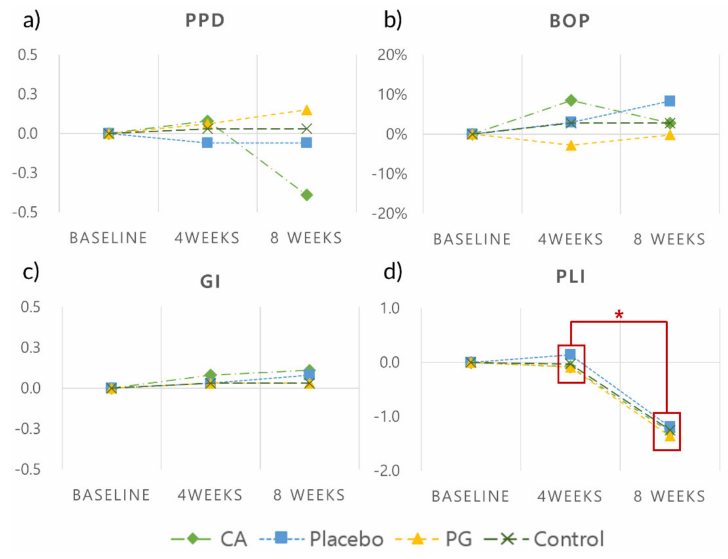
Figure 6. Interval changes of clinical parameters. ( a ) Probing pocket depth (mm); ( b ) bleeding on probing (%); ( c ) gingival index; ( d ) plaque index. * Statistical di ff erence within each group (CA: p = 0.026, placebo: p = 0.027, PG: p = 0.028, control: p =